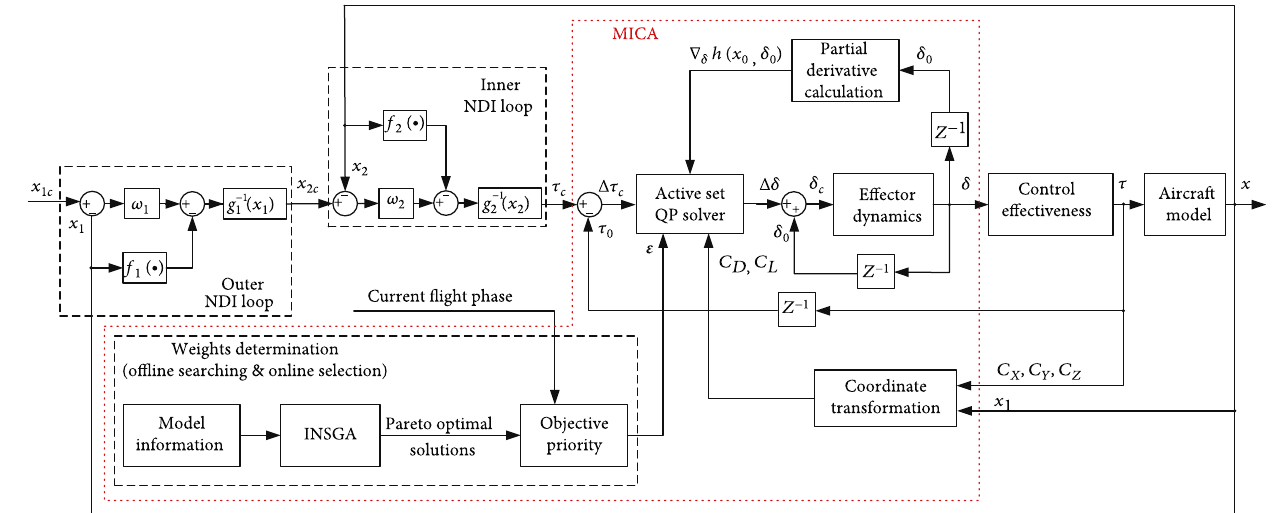
Figure 10: Block diagram of tailless aircraft control system with MICA module.